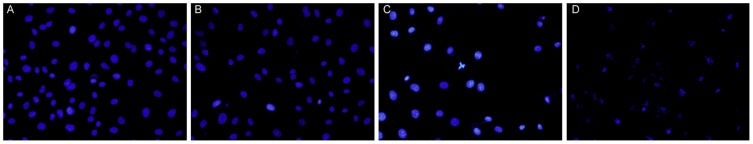
Cells in culture were examined by flurorescence microscopy following staining with DAPI.A Cells treated with 0(magnification, ×200).